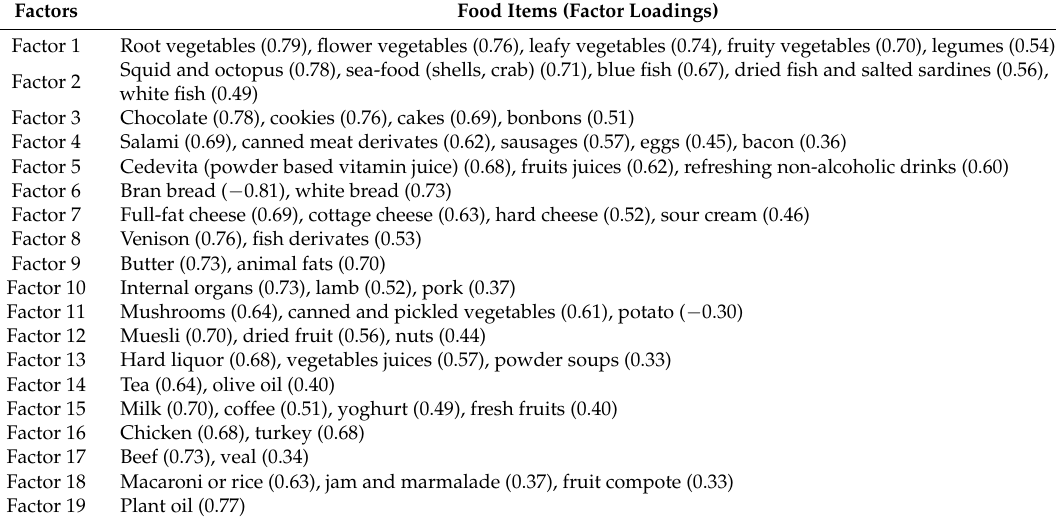
Table 2. List of food items and factor loadings for 19 dietary groups (factors) identified using principal component analysis.